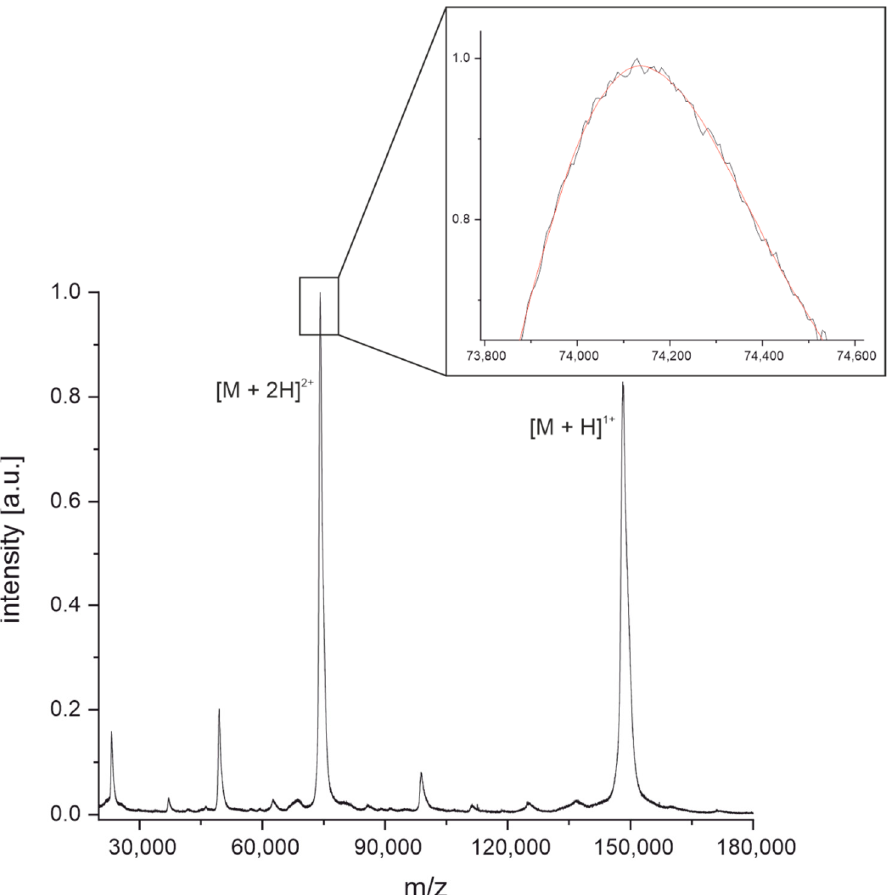
Figure 1. MALDI-TOF mass spectrum of intact NIST-mAb 8671. Intact mass was determined by smoothing the peak of the doubly charged species using a Savitzky-Golay filter with 50 points (inset, red curve) followed by manual peak picking of the maximum of the curve at m/z. The intact mass M was then calculated from the m/z value of the doubly charged species [M + 2H] 2+. In Figure 2, all antibodies used in this work and their mass differences with a confi- dence level of 95% are plotted. Based on their intact masses, distinguishing between certain antibodies is possible. However, many antibodies do not have a unique mass, which means that their confidence intervals overlap with confidence intervals of one or more of the other